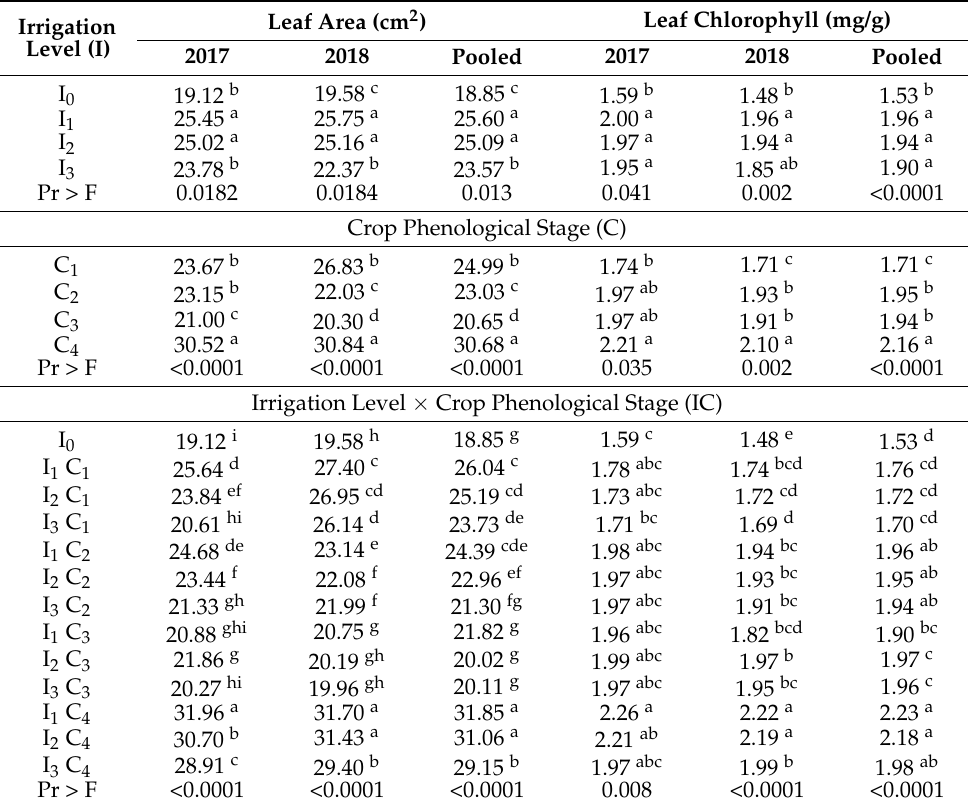
Table 5. Effect of different irrigation levels at various crop phenological stages on leaf area and leaf chlorophyll content (mg/g fresh weight) of apple (cv. Super Chief Sandidge). Leaf Area (cm 2 Irrigation Level (I)